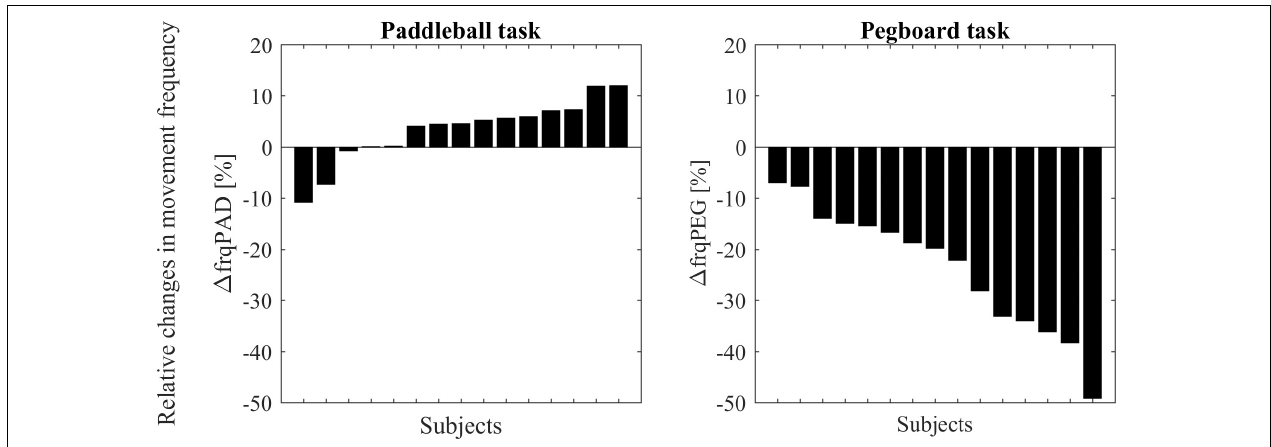
FIGURE 3 | Changes in movement frequencies from single to dual-task condition for all subjects. Subjects are ordered according to effect size. Results for the paddleball task ( (cid:49) frqPAD expressed as % of individual mean frequency) are displayed on the left side. Results ( (cid:49) frqPEG expressed as % of individual mean frequency) for the pegboard task on the right